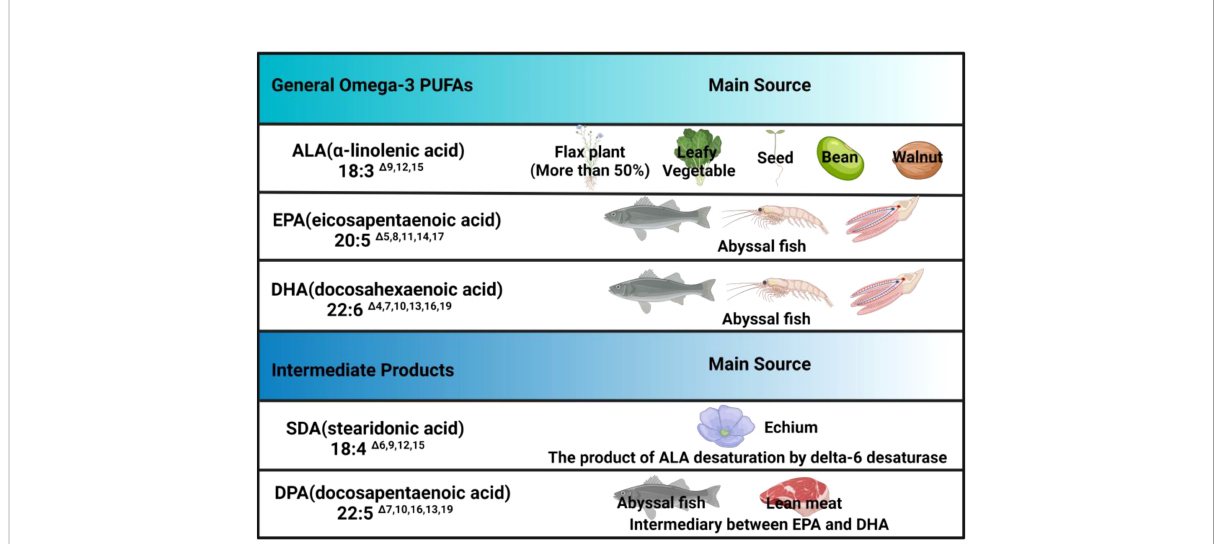
FIGURE 1 Omega-3 PUFAs and their main sources. N-3 PUFAs mainly consist ALA, EPA, DHA and intermediate derivatives, among which only SDA and DPA are listed in the table, but other derivatives, such as eicosatetraenoic acid (ETA), are not included, which means there is a lack of clarity regarding these derivatives